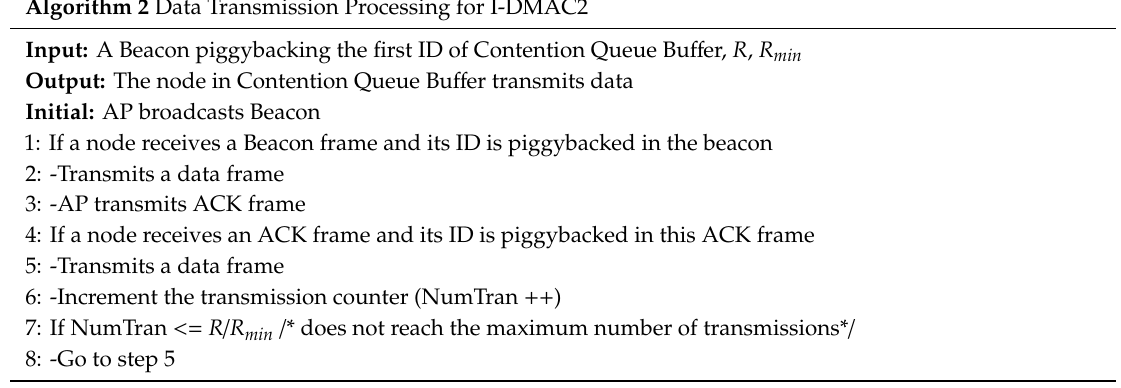
Algorithm 2 Data Transmission Processing for